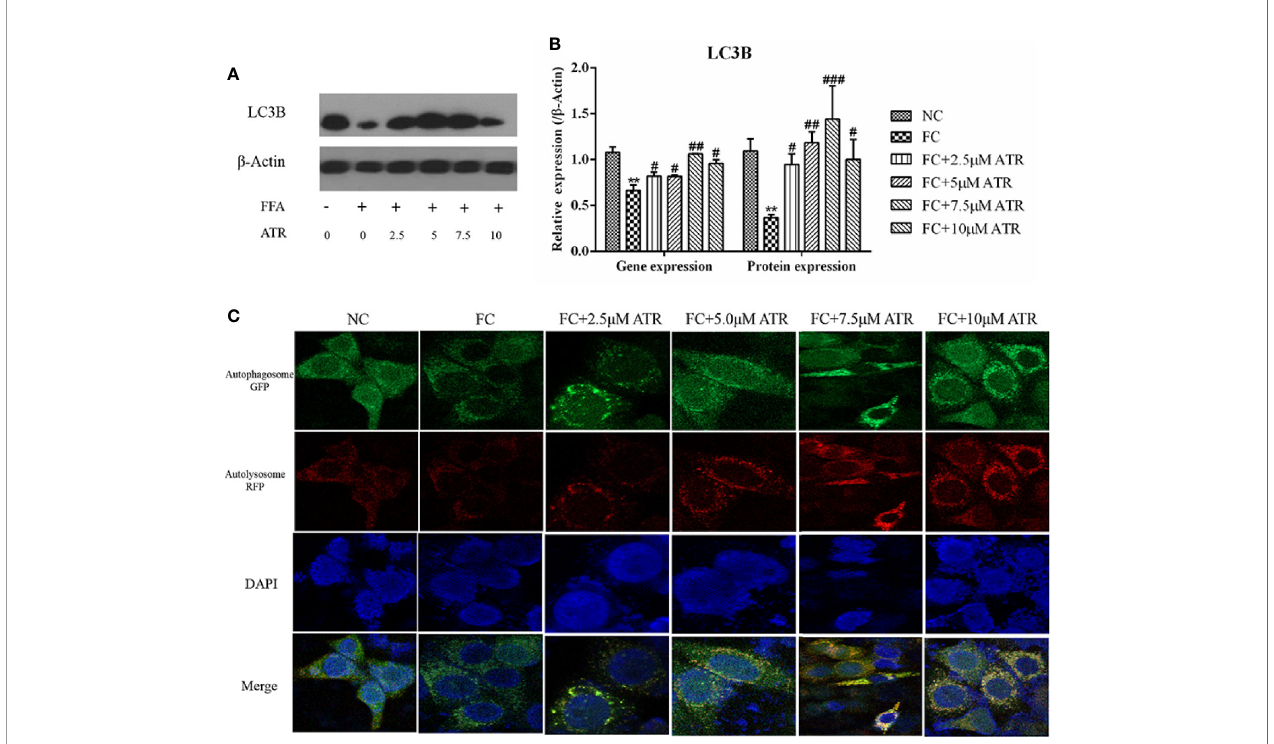
FIGURE 5 | Gene and protein expression of LC3B and autophagic fl ux analysis. (A) Immunoblot analysis for LC3B in reference to b -actin. (B) Gene and protein expression of LC3B in reference to b -actin. (C) Representative confocal images of cells stably expressing mRFP-GFP-LC3. Scale bars: 10 m m. Data are expressed as mean ± SD (n=3). **P<0.01 (*represents the FC group compared with the NC group). # <0.05, ## P<0.01, ### P<0.001 ( # represents FC+ATR treatments compared with the FC group). NC=normal group, and FC=FFA